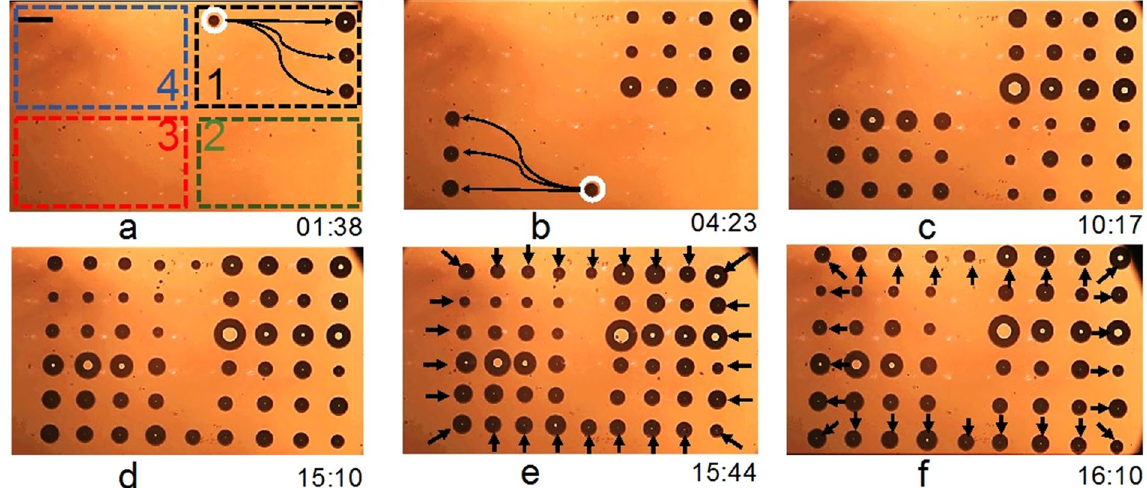
Figure 4. Generation and independent actuation of 50 OFB microrobots in parallel. ( a ) Top view of the workspace, virtually divided into four quadrants as labeled. The OFB microrobots were serially generated by the laser spot marked with the white circle. After generation, the bubbles were moved along trajectories indicated by the arrows using additional actuation laser spots. ( b ) Twelve OFB microrobots were generated in quadrant 1. Each microrobot is held in place by its own dedicated actuation laser spot. The laser beam marked with the white circle nucleated the microrobots at quadrant 3, following the same procedure used for the microrobots in quadrant 1. ( c ) and ( d ) Fifty microrobots were serially nucleated by the laser beams marked with the white circles in ( a ) and ( b ). ( d ) As the serial nucleation occurred in quadrants 1, 3, 2, and 4, the microrobots were assembled in a rectangular matrix. ( e ) The array of 50 microrobots was made to contract towards the center of the workspace (arrows indicate the approximate direction of motion during this operation). To complete the contraction operation, each microrobot needed to move in a different direction, thus demonstrating the independent actuation of 50 OFB microrobots in parallel. ( f ) The array of microrobots was expanded outwards, demonstrating the parallel, independent actuation of each microrobot in a different direction (arrows indicate the approximate direction of motion). Scale bar: 150 µ m. Time format: